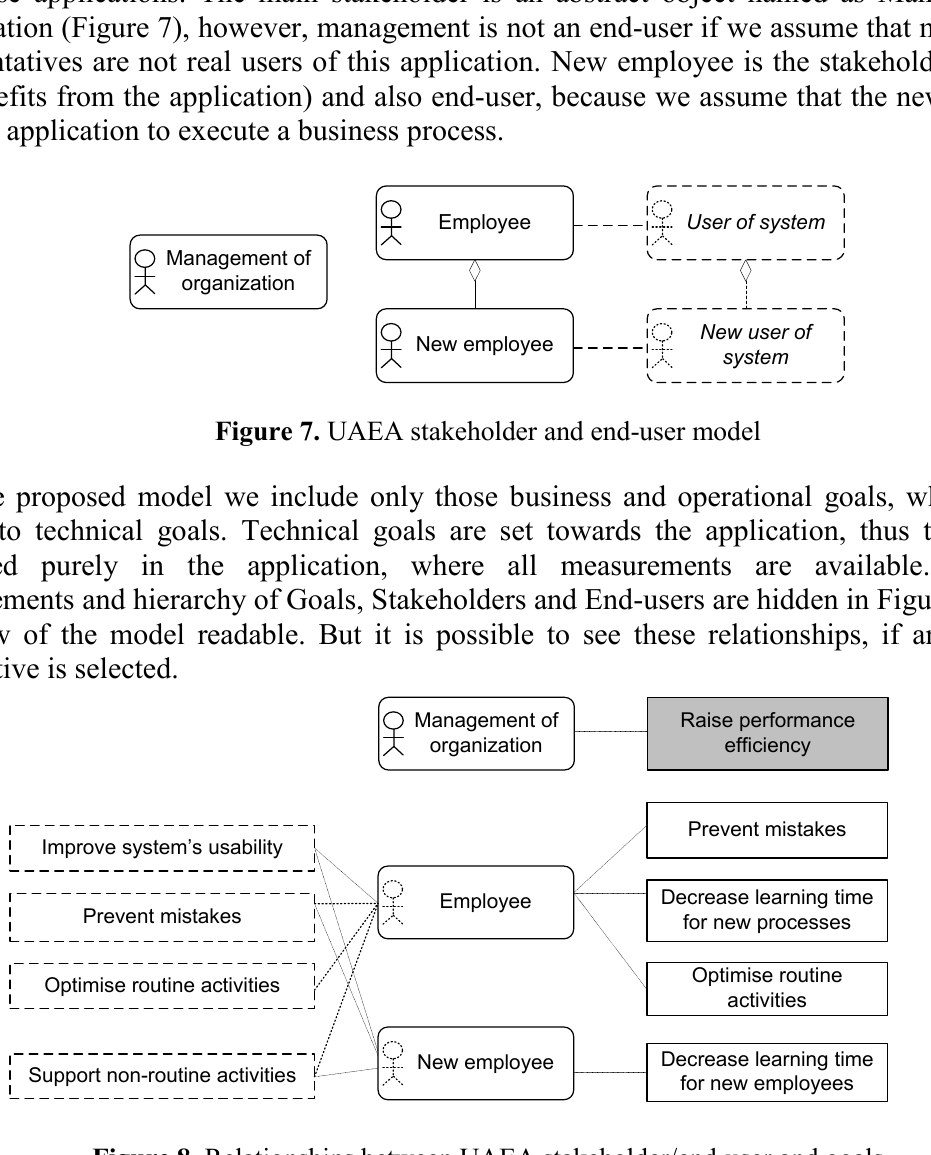
Figure 8. Relationships between UAEA stakeholder/end-user and